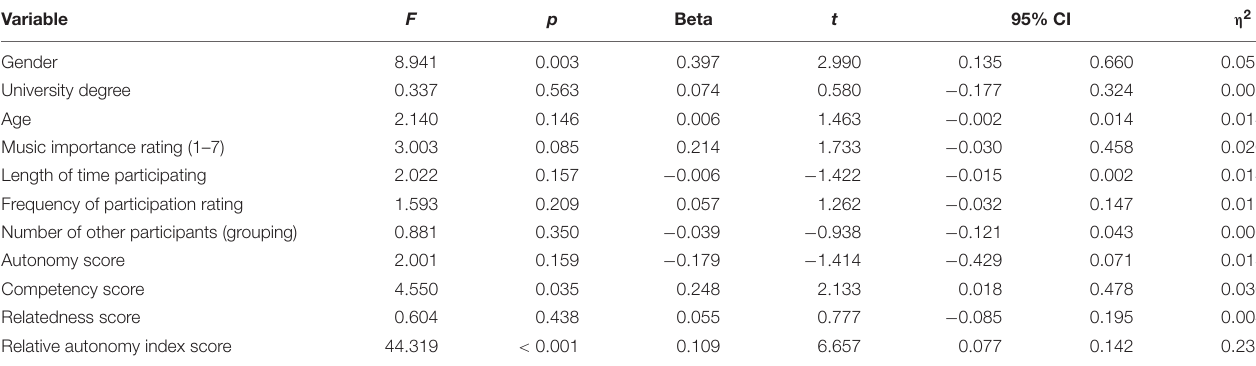
TABLE 4 | Esteem and worth well-being score model.